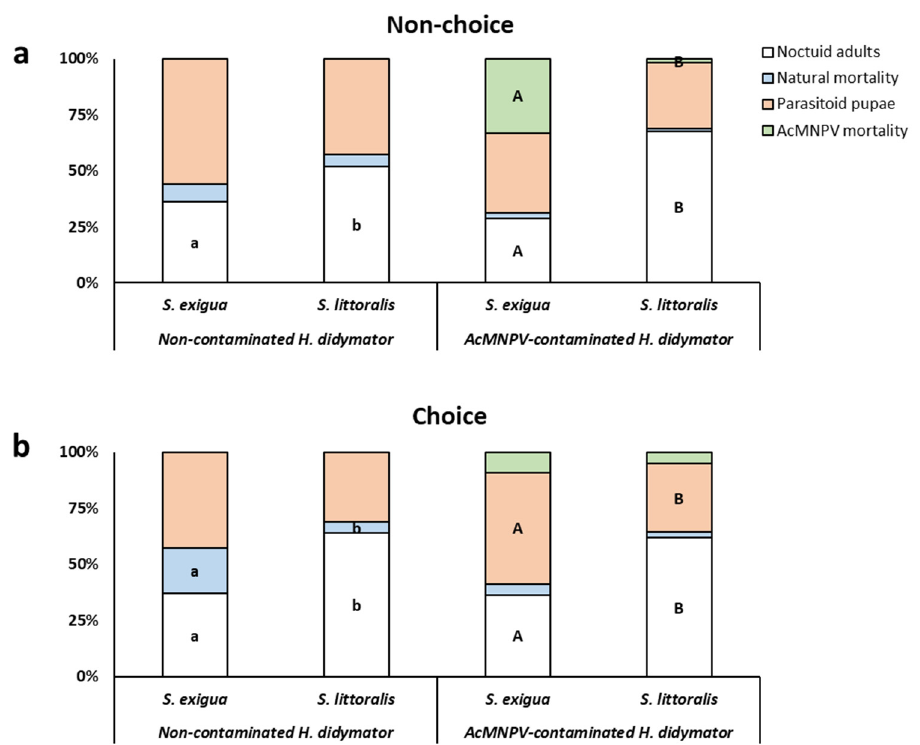
Figure 3. Preference of Hyposoter didymator females for Spodoptera exigua and Spodoptera littoralis larvae, when non-contaminated females and females contaminated by Autographa californica multiple nucleopolyhedrovirus (AcMNPV) after previous exposure to infected larvae. Cumulative bars show the following parameters: Percentages of larvae dead by AcMNPV infection (green), larvae dead by parasitism (orange), larvae dead by natural causes non-attributable to the aforementioned (blue), and healthy Spodoptera adults that completed their development (white). Lowercase letters stand for significant differences between the host species within a parameter, in the case of non-contaminated H. didymator females. Uppercase letters stand for significant differences between the host species within a parameter, in the case of AcMNPV-contaminated H. didymator females. ( a ) Non-choice conditions; ( b ) choice conditions.